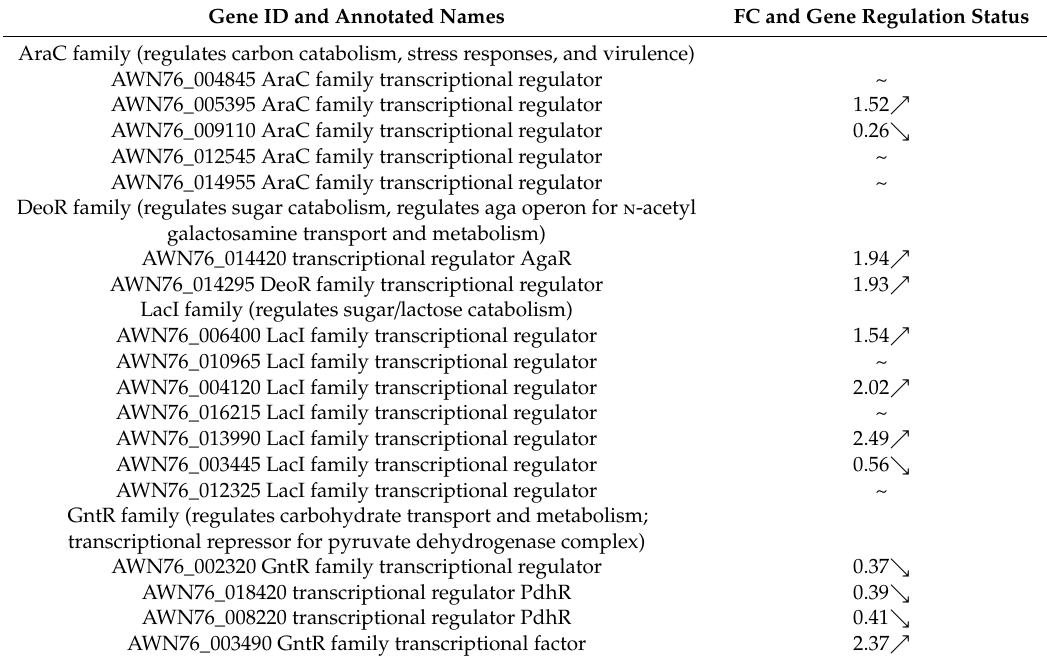
Table 3. Fold change of transcriptional factors identified in strain